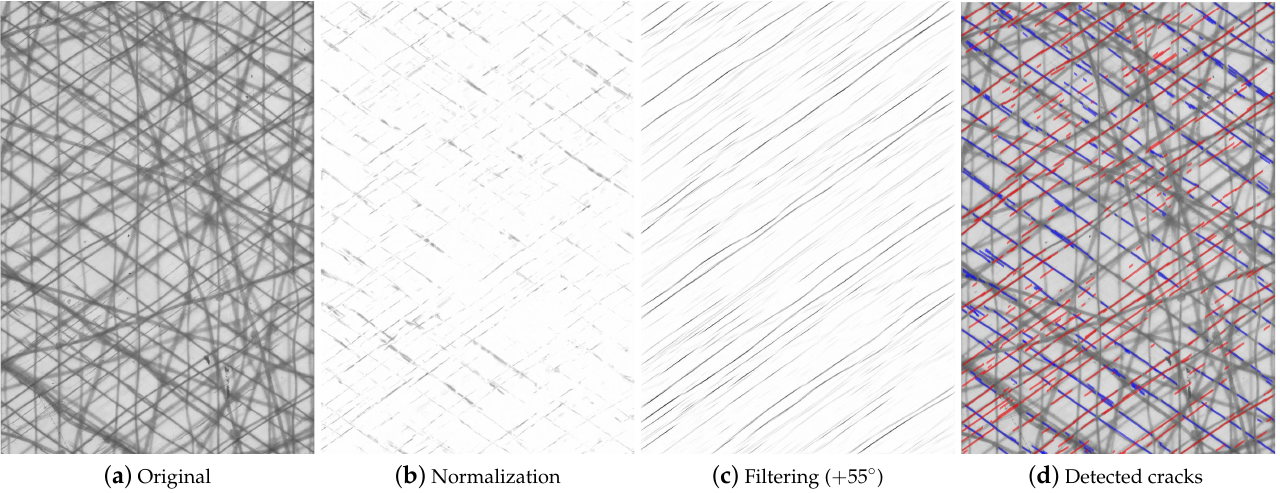
Figure 5. ( a ) Original image of a cracked specimen after n = 5 × 10 4 loading cycles and results of the proposed image processing technique after ( b ) normalization and ( c ) G ABOR filtering perpendicular to the + 55°-direction. Detected cracks within the − 55° (blue) and + 55° layers (red) are plotted together with the original image in ( d